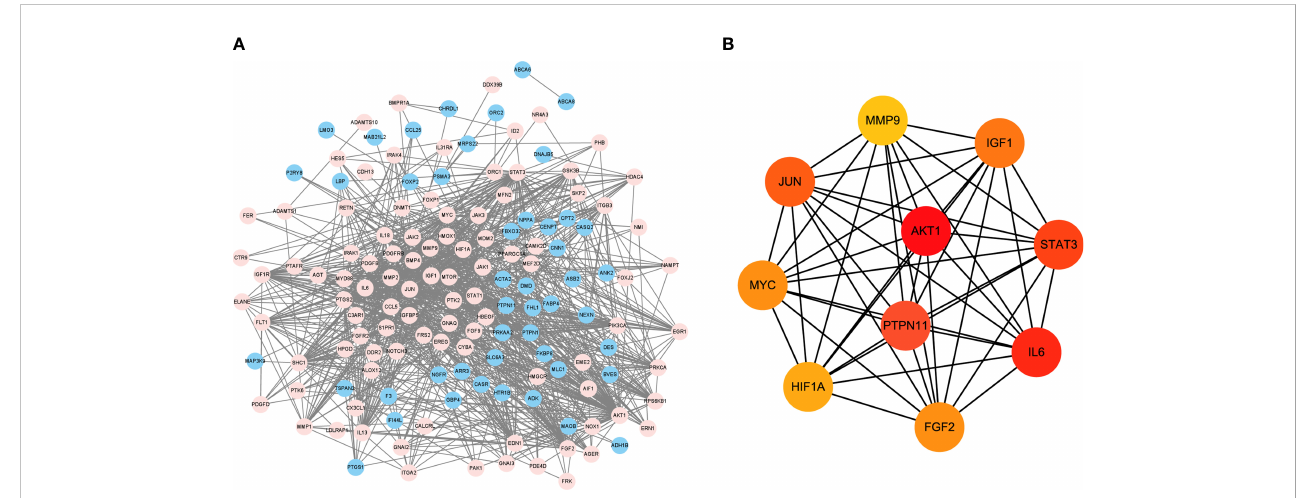
FIGURE 3 PPI network analysis of DEGs and target gene screening. (A) DEGs were imported into STRING database to obtain PPI network. Blue represents the down-regulation, and pink represents the up-regulation; (B) The sub-network of hub genes were constructed, and hub genes were calculated using the degree algorithm. DEGs, differentially expressed genes; PPI, protein-protein